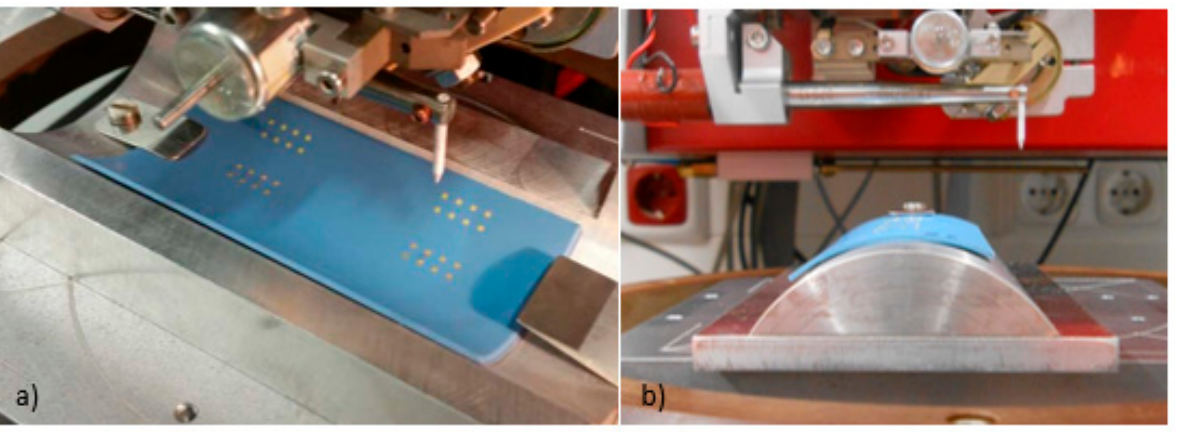
Figure 5. Adaption of the bonder Delvotec 5410 to shaped LTCC substrates: ( a ) concave shape for bonds on the inner diameter and ( b ) convex shape for bonds on the outer diameter.